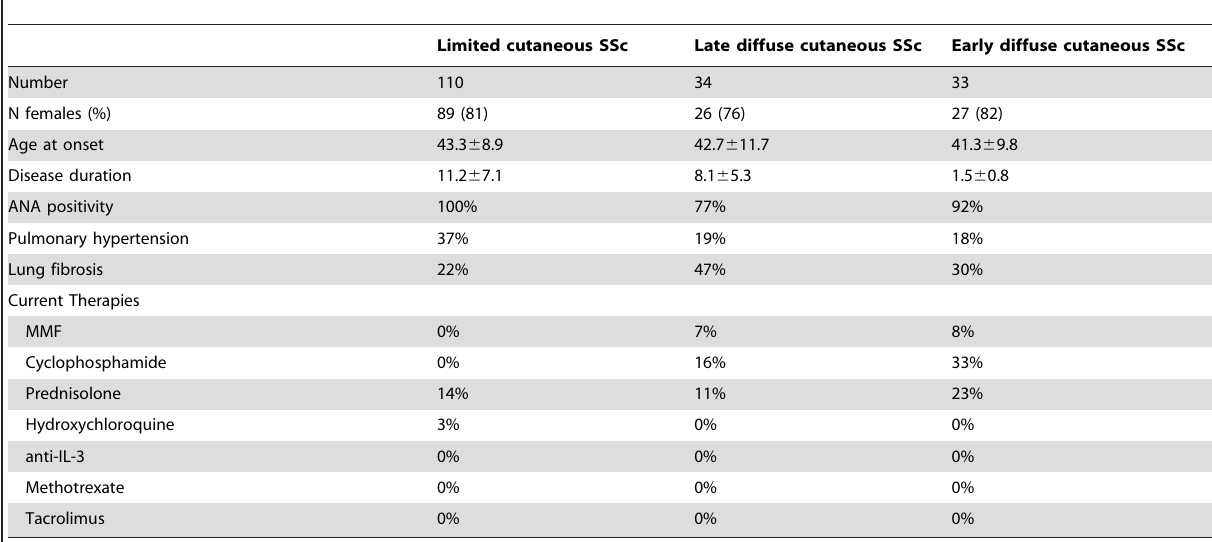
Table 3. Clinical characteristics of patients used for measurement of circulating